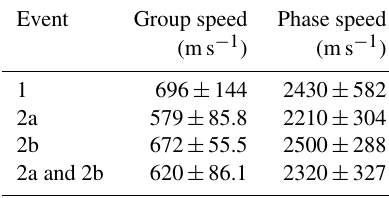
Table 1. Mean group speeds and mean phase speeds of the FAEs within each event. The uncertainties given here are the standard de- viations across all measurements within the